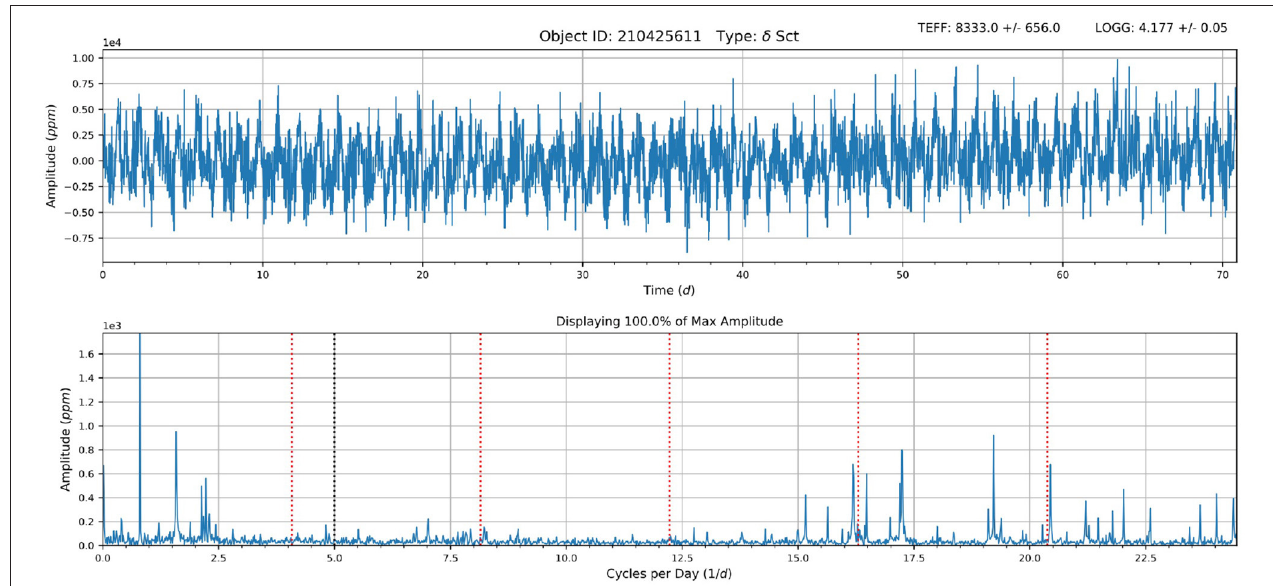
FIGURE 3 | Light curve (Top) and amplitude spectrum (Bottom) for brightest δ Sct variable EPIC 210425611 (also known as h Tau, V483 Tau, and 57 Tau), with Kp magnitude 5.6, observed during C4. The red dashed vertical lines in the amplitude spectrum mark multiples of the spacecraft roll correction frequency, 4.075 c/d.